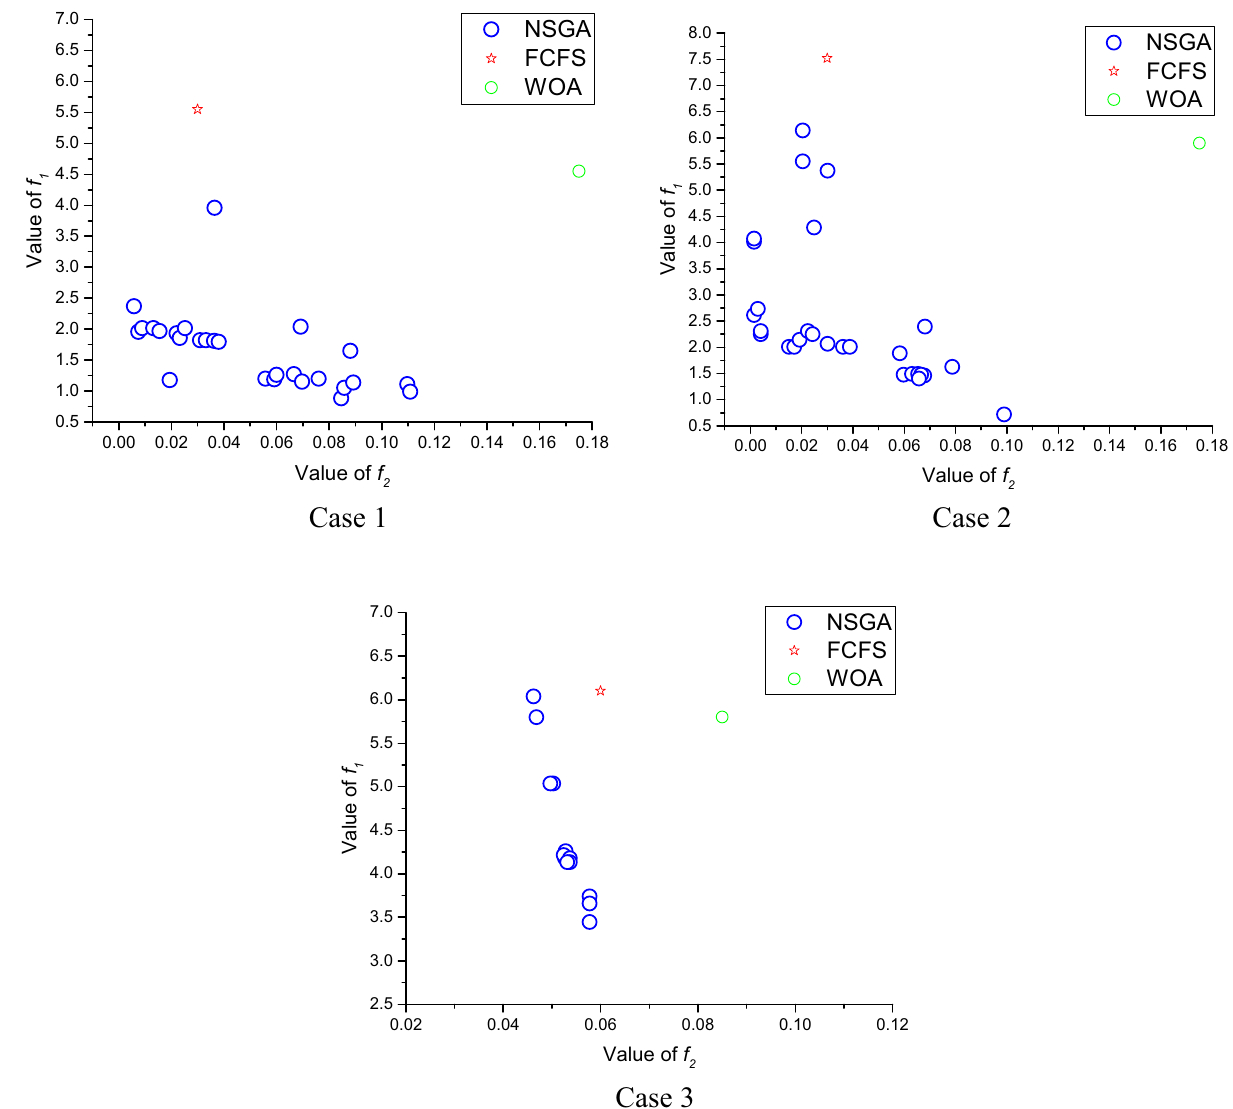
Figure 10. Distribution of objective function attributes in different theory